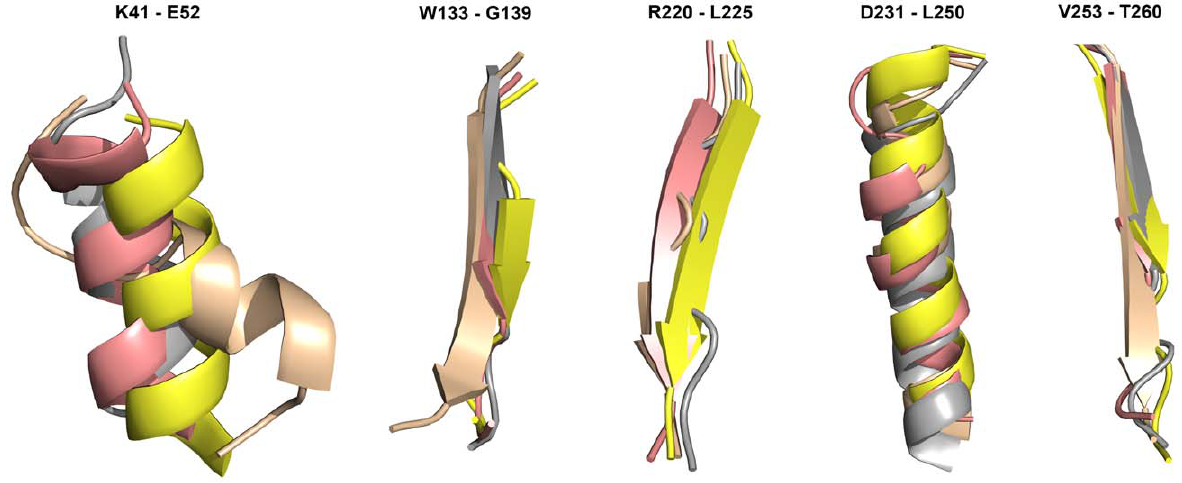
Figure 8. Secondary structural changes observed in HDAC11 WT and mutational systems. Initial and MD average structure of HDAC11 WT is shown in yellow and wheat color. L268M and L268E systems are shown in salmon and grey